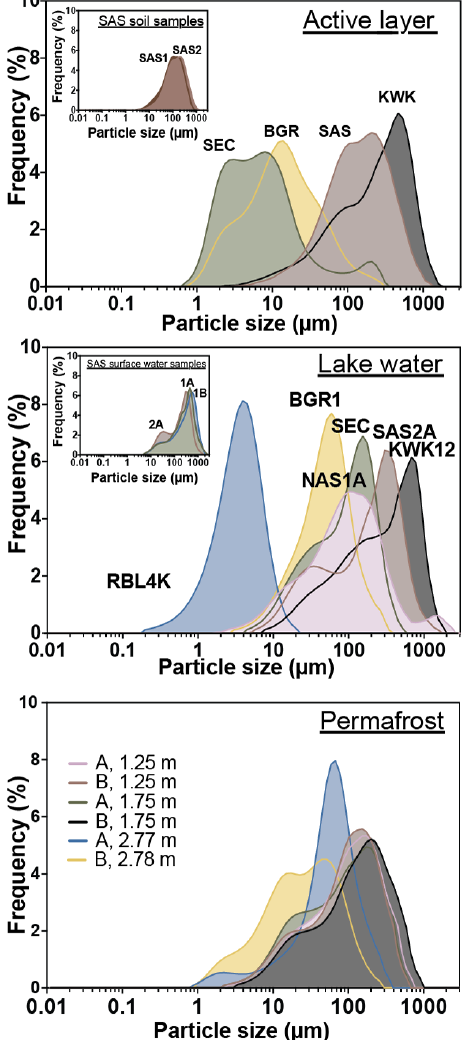
Figure 4. Distribution of particle sizes in lake water and permafrost soil samples. Insert in the top panel shows the soil sample particle- size distribution for both SAS valleys. The insert in the middle panel shows the particle-size distribution in three SAS lakes: SAS1A, SAS1B, and SAS2A. The bottom panel shows the particle-size dis- tributions from the SAS2 permafrost core samples.